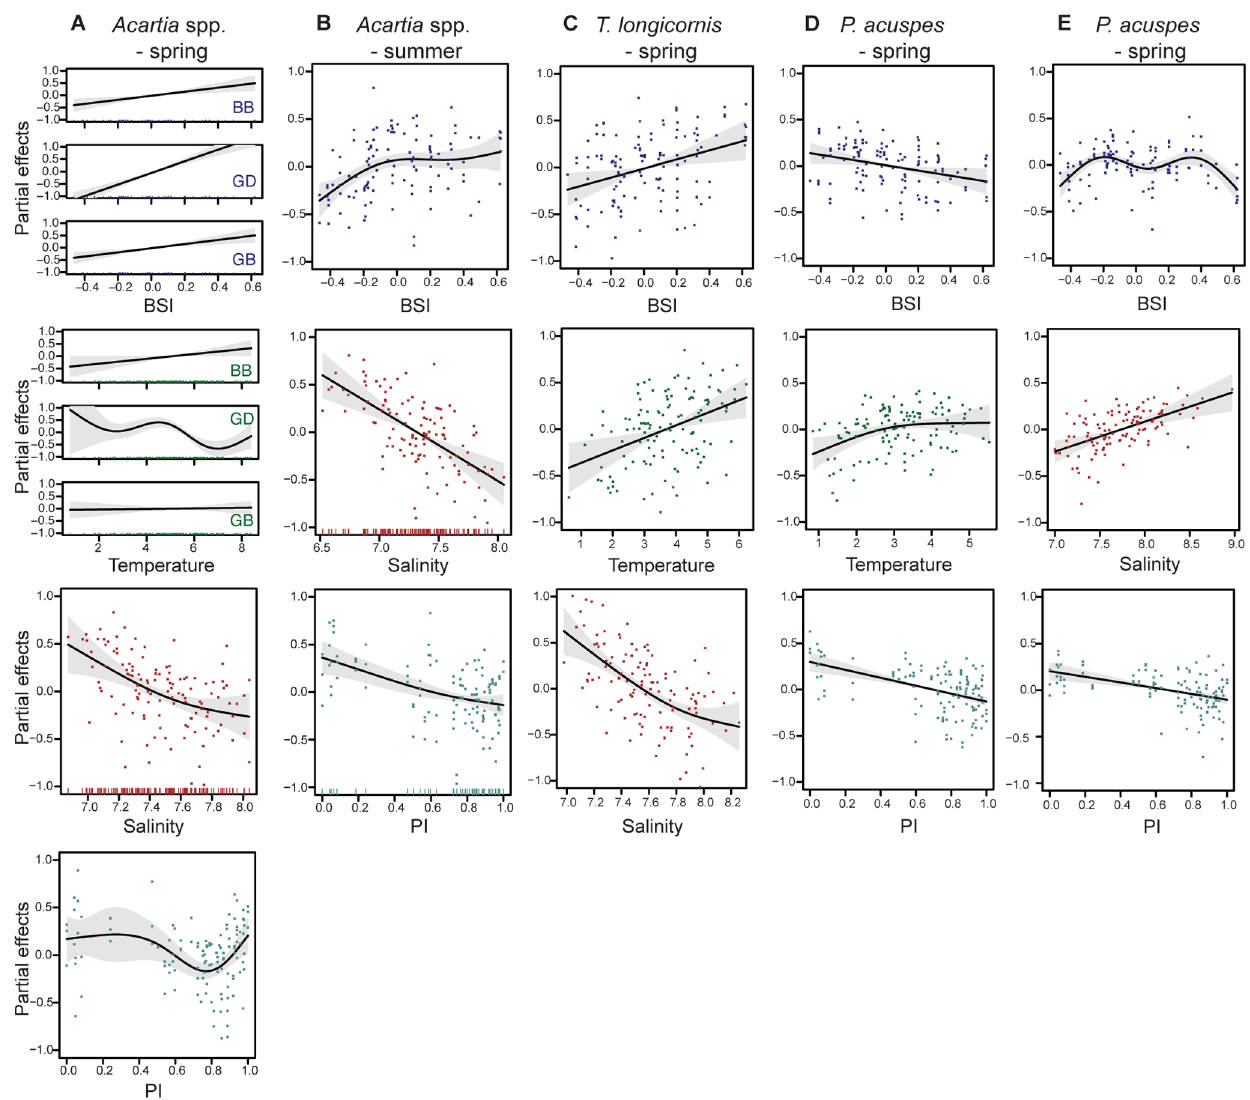
Figure 3. Statistical model results of Acartia spp., T.longicornis , and P.acuspes . Partial plots of significant covariates in the final spring and summer GAMs are presented for each basin separately or together depending on the significance and model performance. Values on the y-axis indicate the effect that the term on the x-axis has on the biomass anomaly. The solid lines indicate the smoothed (non-) parametric trend, shaded areas indicate the pointwise 95% CI.